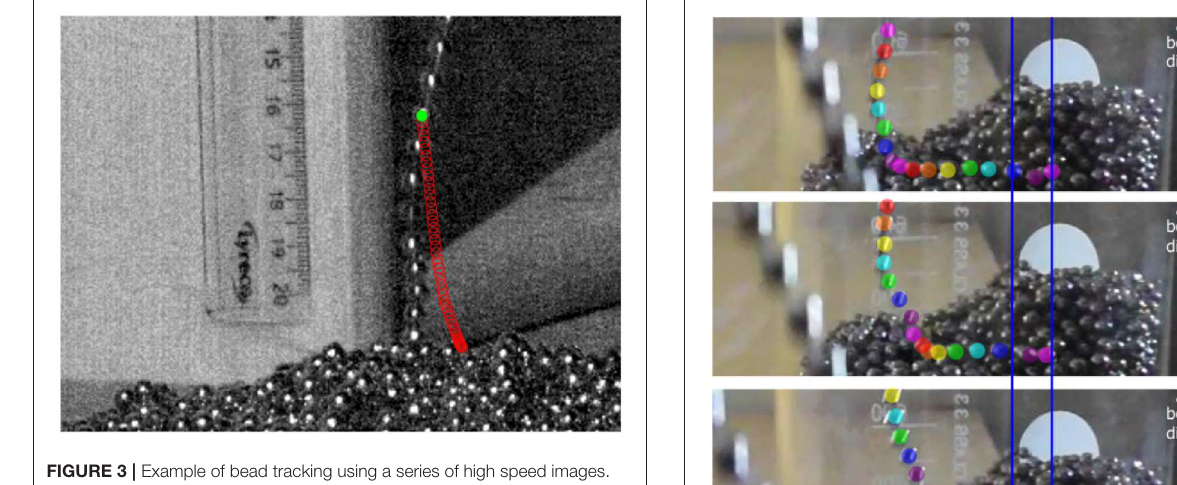
FIGURE 3 | Example of bead tracking using a series of high speed images. The filled green circle corresponds to the current position of one particular bead being tracked and the red open circles correspond to later positions of the same bead. The tracking lasts for 50 frames here corresponding to a time span of 12.5 ms.